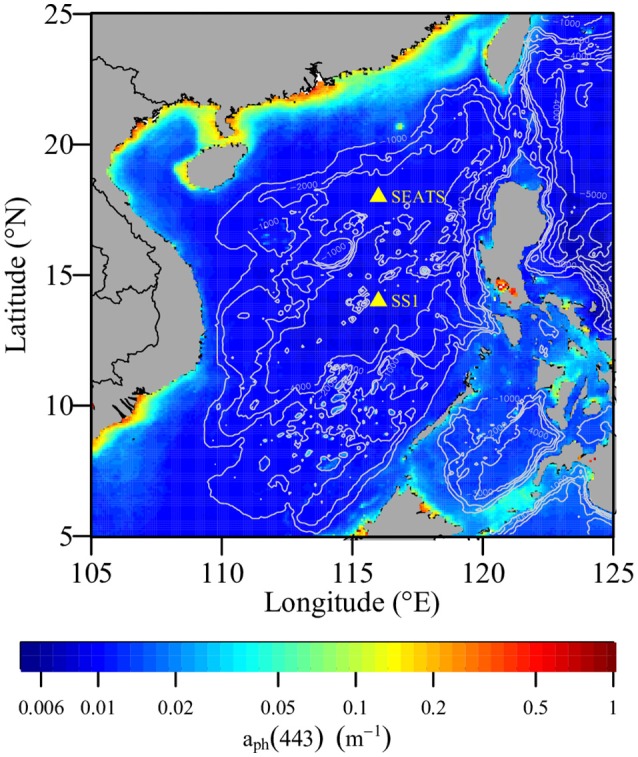
Sampling stations in the South China Sea in June 2017. In the background, the contour lines are water depths, and the color contour is climatologic phytoplankton absorption coefficient at 443 nm in June that is MODIS-Aqua QAA-aph(443) downloaded at https://oceancolor.gsfc.nasa.gov/cgi/l3.